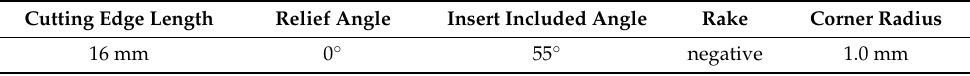
Figure 6. The cutting tool: ( a ) Holder of type CKJNL; ( b ) Cutting tool insert KNUX. Table 5. Cutting tool geometric data.